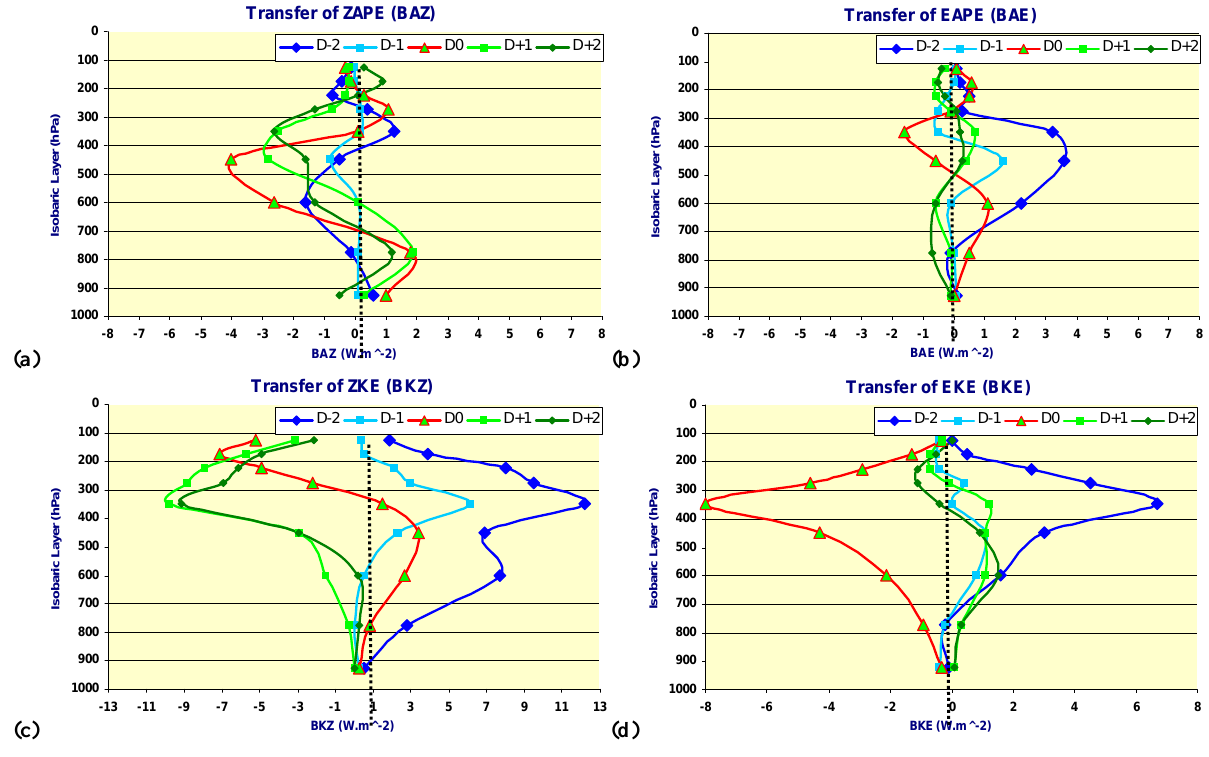
Fig. 15. Energy transfers of (a) ZAPE, (b) EAPE, (c) ZKE and (d) EKE on 27 (D-2), 28 (D-1), 29 (D0), 30 (D+1) and 31 January 2008 (D+2).